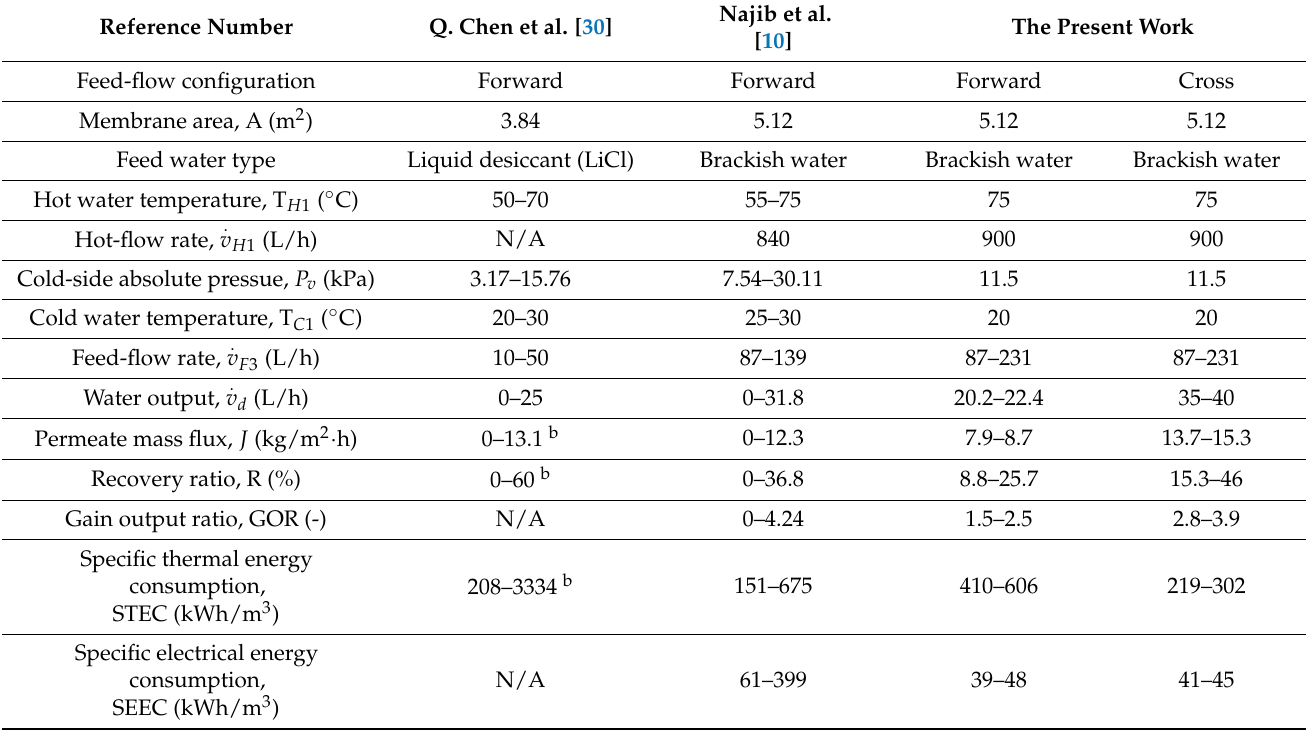
Table 5. Comparison of the present results with those of